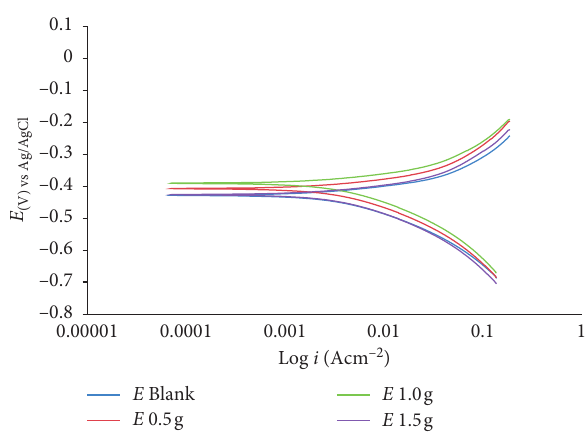
Figure 6: Potentiodynamic polarization curve of mild steel in dilute H 2 SO 4 in the absence and presence of MBZ at 30 °